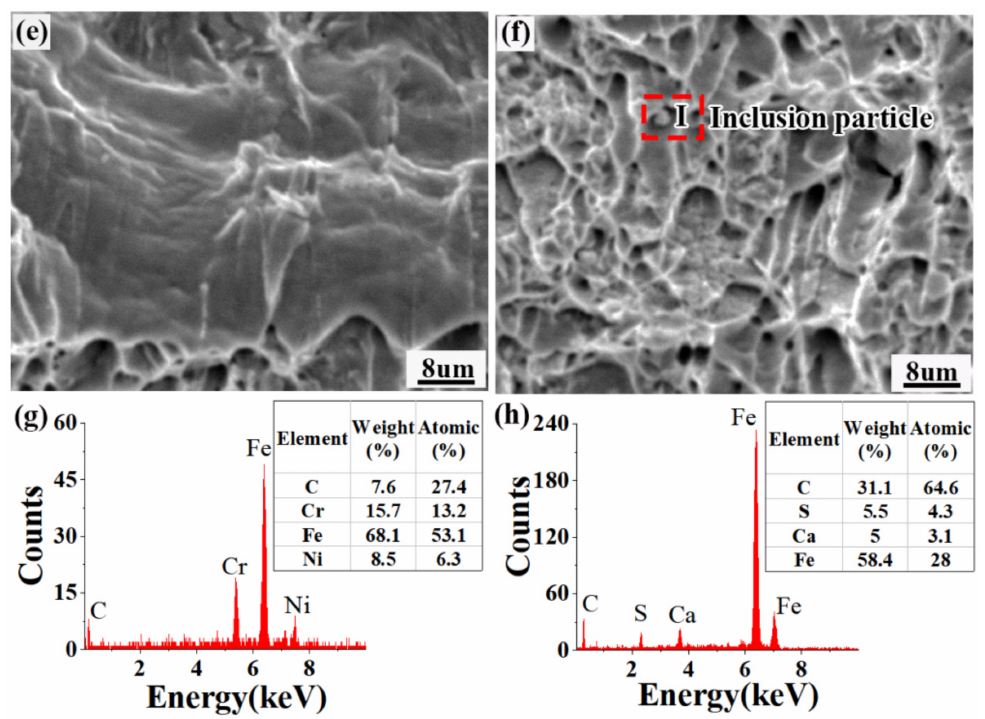
Figure 14. Tensile specimen fracture morphology: ( a ) macroscopic morphology of the tensile fracture; ( b ) microscopic morphology of the composite interface; ( c ) microscopic morphology of the stainless steel matrix zone; ( d ) microscopic morphology of the composite zone; ( e ) microscopic morphology of the decarburised zone; ( f ) microscopic morphology of the carbon steel matrix zone; ( g ) compositional analysis of precipitates from the composite zone; ( h ) compositional analysis of precipitates from the carbon steel matrix.